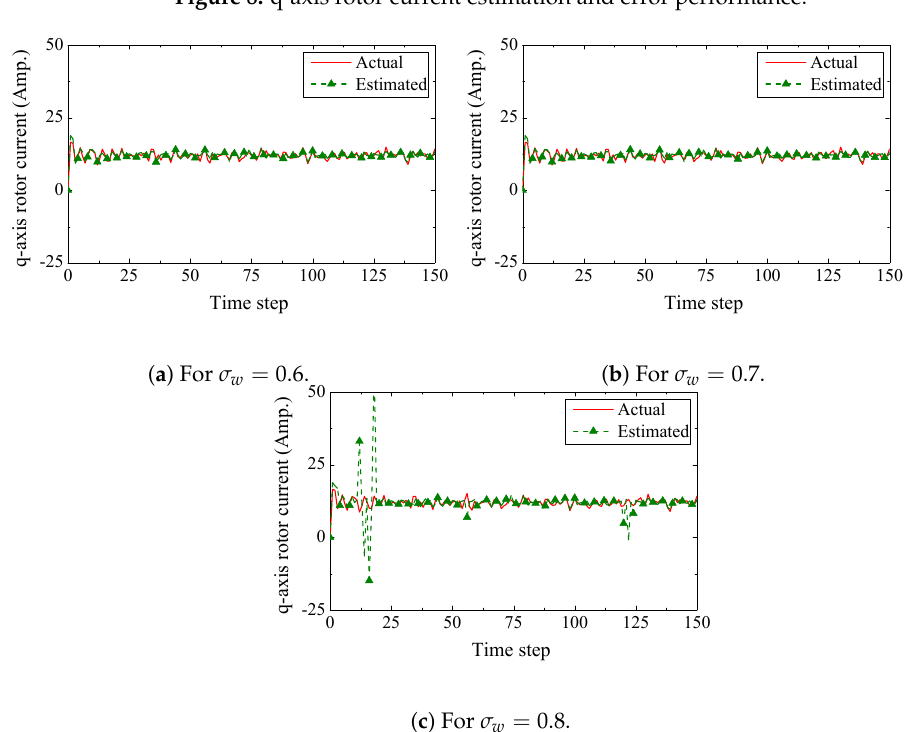
Figure 9. Impact of wireless channel quality on estimation